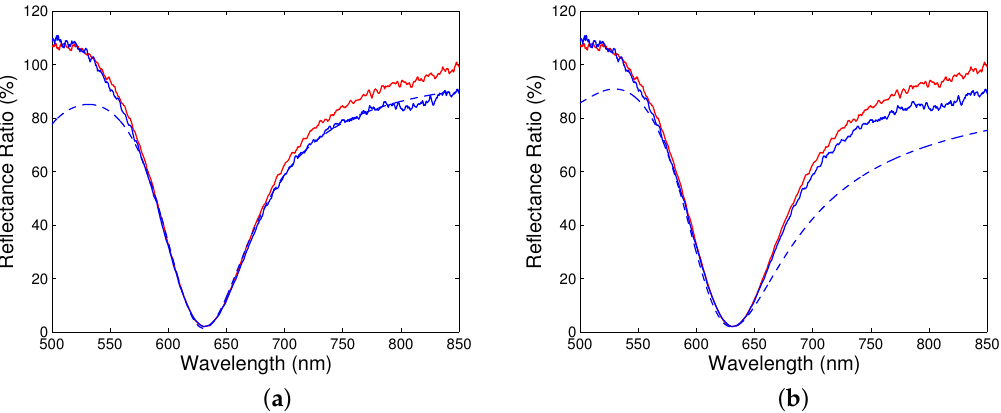
Figure 5. Measured (solid curves) reflectance ratio R p ( λ ) / R s ( λ ) as a function of the wavelength for angle of incidence α = 40.6 ◦ together with the fitted one ( a ), and with the modelled one ( b ). Lower solid curve corresponds to a different loop diameter of a read optical